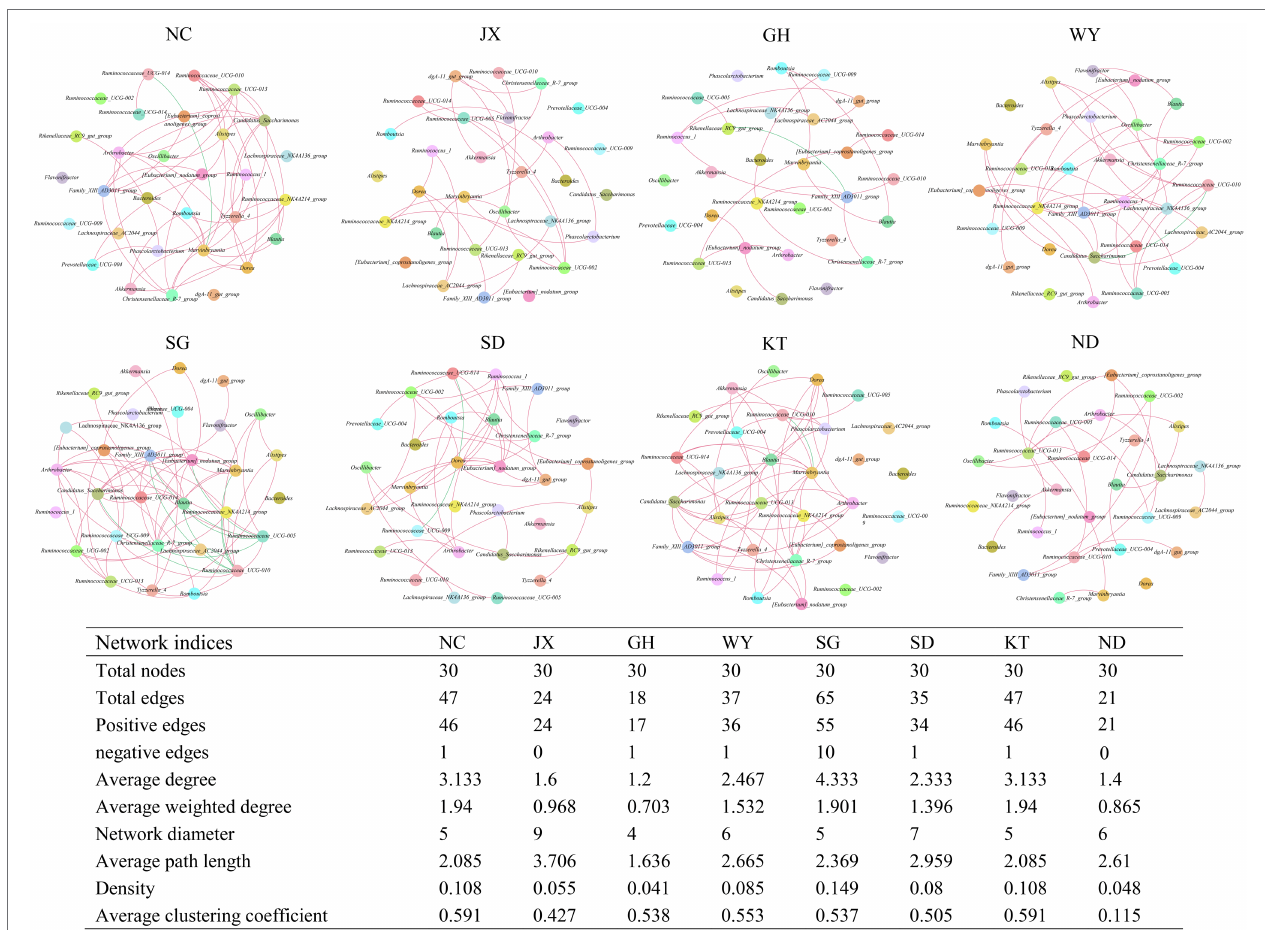
FIGURE 8 | Co-occurrence networks of the 30 most abundant genera in Przewalski’s gazelle from eight different areas. Each line represents Pearson correlation coefficient, whose absolute value was higher than 0.5 and p value was less than 0.05. The red and green lines represent positive and negative correlations,